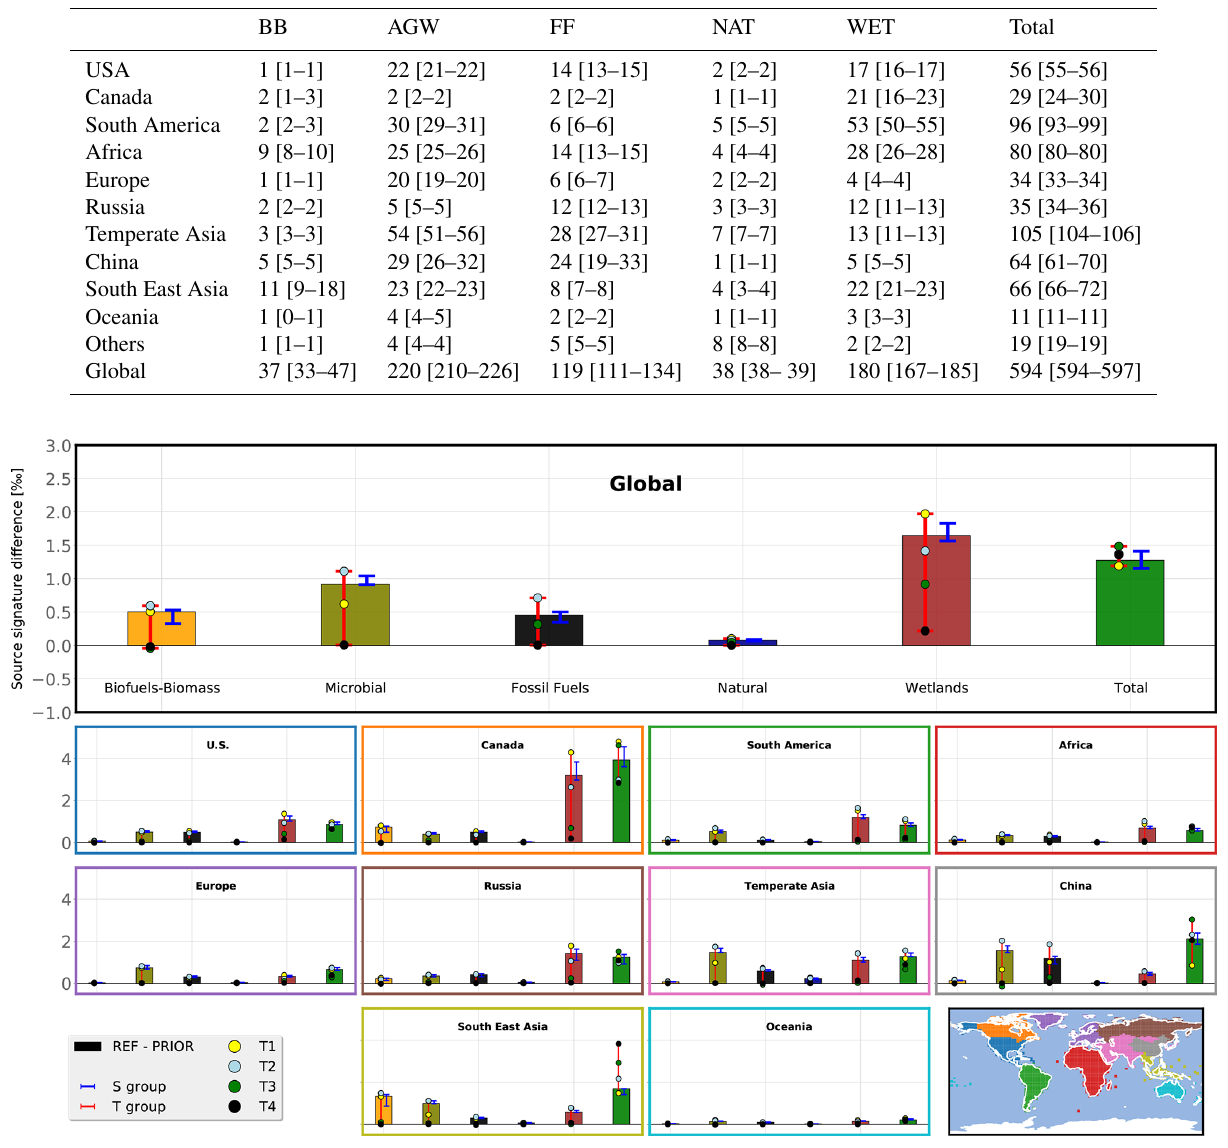
Figure 7. REF flux-weighted source signature increments for the 2014–2015 period. The color-filled bars show the differences between REF posterior and prior estimates (REF increment). The upper panel refers to the global emissions. The lower panels refer to multiple regions of the globe. The regions are shown on the lower right panel. Red and blue error bars represent the minimum and maximum of the T group and S group, respectively. Circles on error bars show the results from the T